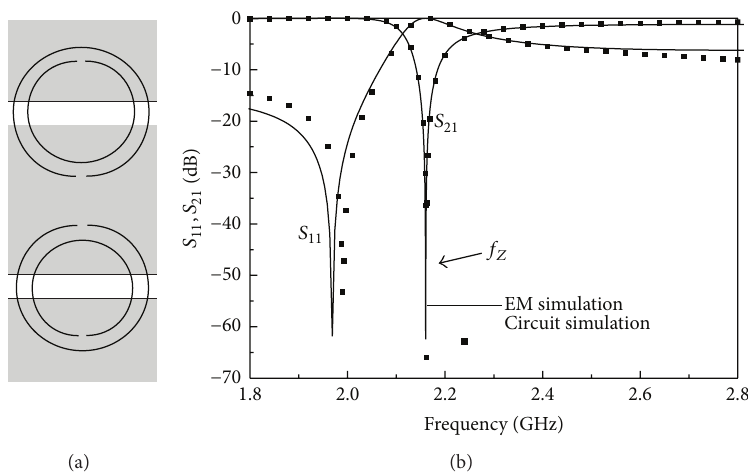
= 0.36 mm, inner ring width 𝑐 = 0.37 mm, out inn